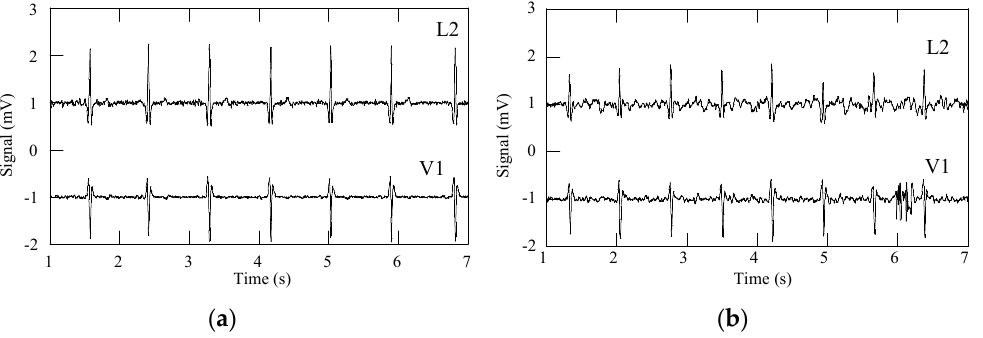
Figure 10. ECG signals L2 and V1, after removal of wander interference: ( a ) subject standing; and ( b ) subject walking.